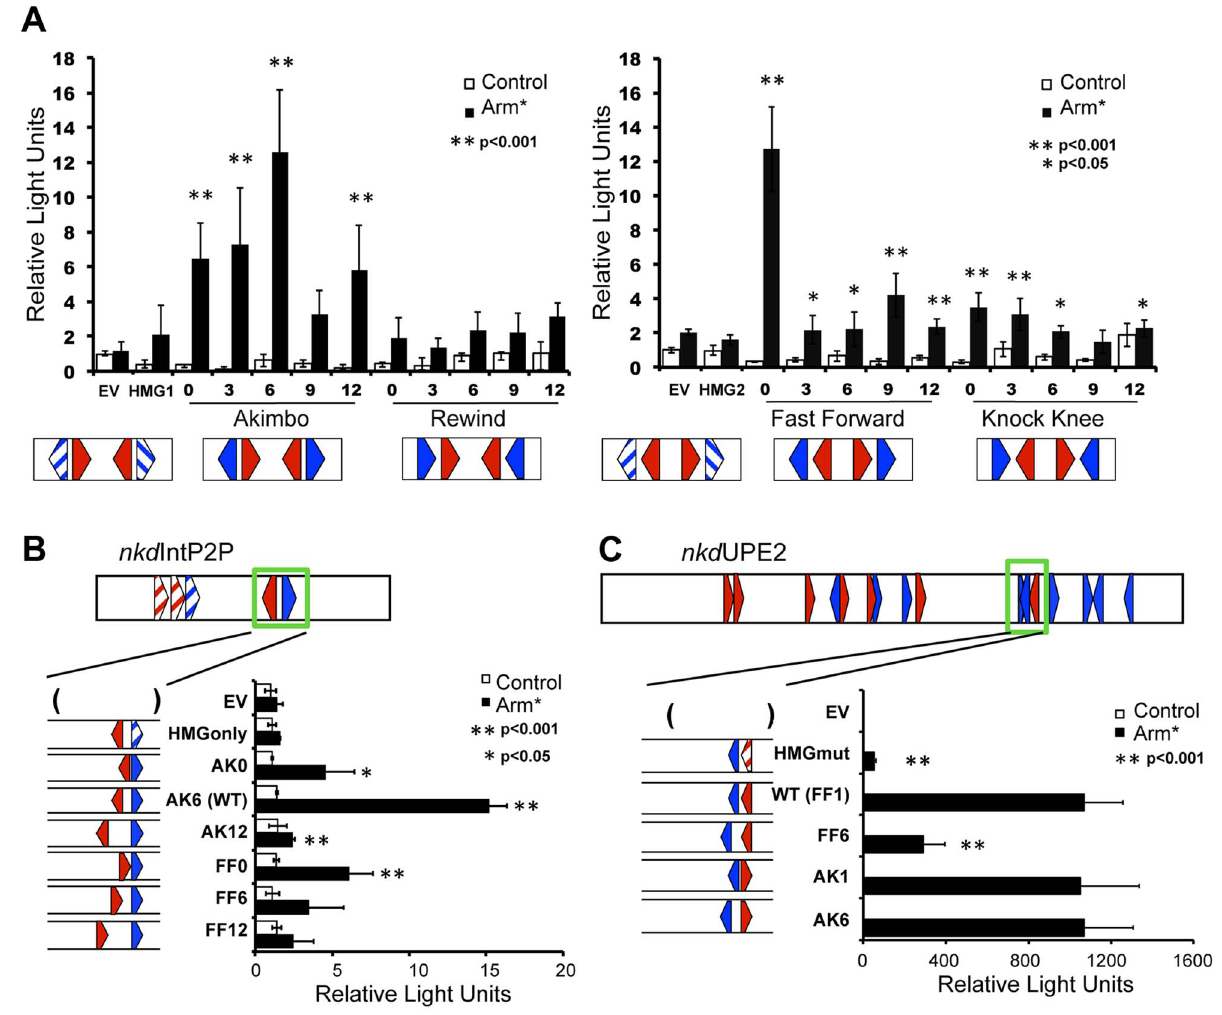
Figure 3. HMG-Helper pair configuration preferences in cell culture reporter assays. Kc cells were transfected with the indicated reporters with or without a plasmid expressing Arm* and assayed for luciferase expression. (A) Synthetic W-CRMs containing two HMG-Helper site pairs in all four orientations with 0, 3, 6, 9 or 12 bp spacing between the HMG and Helper site (see Table S1 for sequences of each synthetic W-CRM). In every construct, the two pairs were separated by 6 bp. Two constructs containing only HMG sites (HMG1 and HMG2) were included in the analysis and the reporter vector without an insert is referred to as empty vector (EV). The data shown represents the average of three independent experiments with three biological replicates each. Error bars represent SD and asterisks indicate a significant difference in activation compared to HMG site constructs. (B) The cartoon at the top of the panel depicts the nkd IntE2P2 W-CRM, all HMG and Helpers sites were mutated (striped arrowheads) except one AK6 pair (green box). The spacing and orientation of this pair were altered as indicated. The endogenous AK6 configuration displayed the highest level of activation by Arm*, while AK0, AK12 and FF0 constructs also exhibited higher activation than the HMG site only control. The data are the means of two independent experiments with three biological replicates each, 6 SD. Asterisks indicate a significant increase in activation compared to the HMG site only construct. (C) In the nkd UPE2 W-CRM, the HMG and Helper site pair (green box) which contributes most potently to activation [57] was altered as indicated. AK1 and AK6 configurations responded as well as the endogenous FF1 pair, while the FF6 configuration was less active. The data are the means of three biological replicates 6 SD, and are representative of several independent experiments. Asterisks indicate reduced activation by Arm* compared to the wild-type construct. In all cases, Student’s T-tests were employed to determine